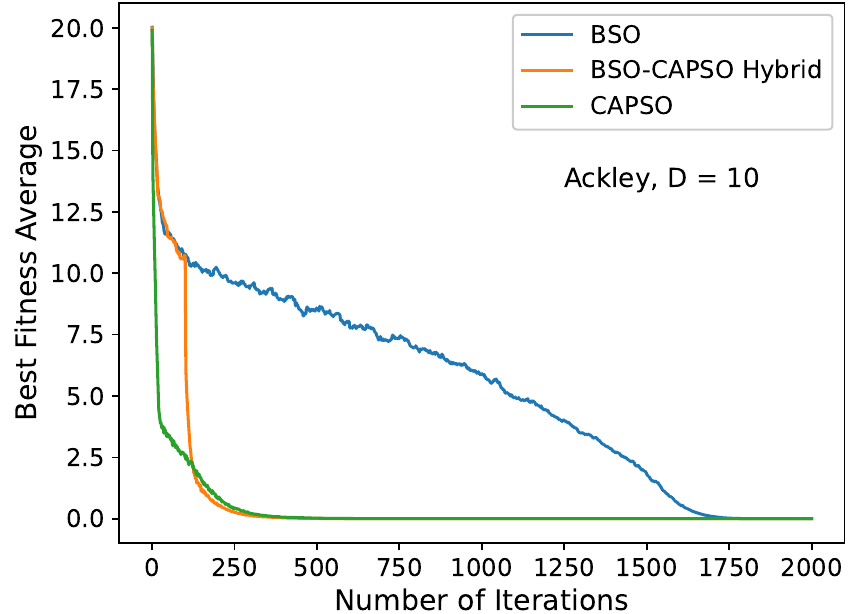
Figure 3. Convergence diagram of the stand-alone BSO, BSO–CAPSO hybrid and CAPSO algorithms for the Ackley ( f 5 ) function with D = 10. Convergence acceleration occurred after t switch =